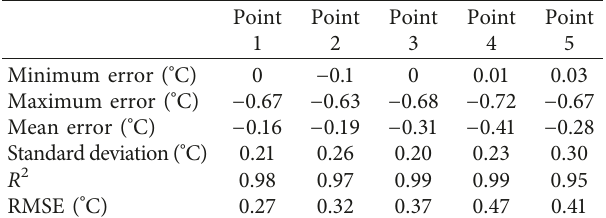
Figure 5: Comparison between simulated and measured mean radiant temperatures. Table 5: Model fit between simulated and measured results for air temperature.